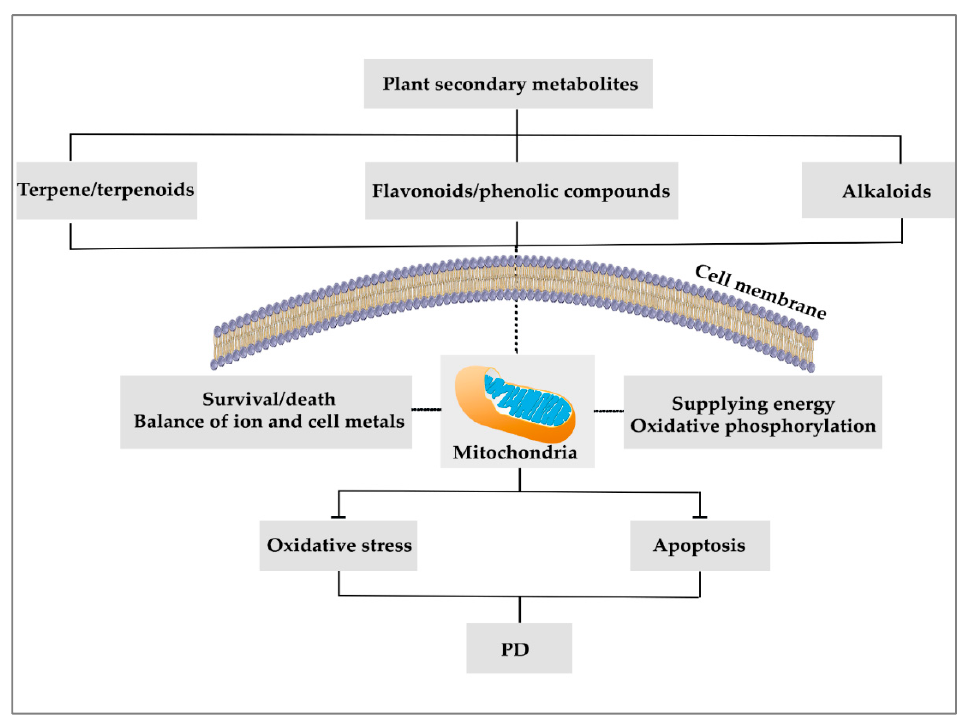
Figure 1. The potential of phytochemicals in the attenuation of mitochondria-related functions. 4. Modulation of PD by Phytochemicals through Targeting Mitochondria